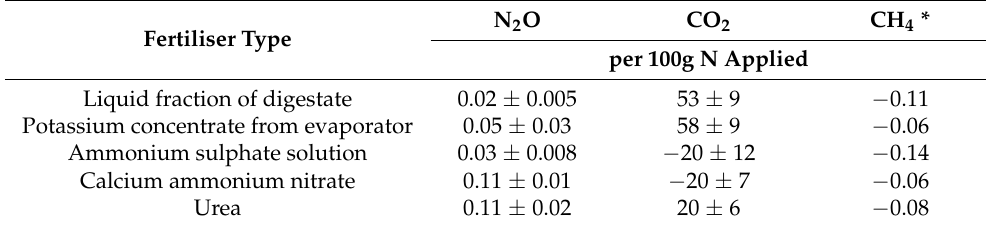
Table 5. Emission factors of nitrous oxide (N 2 O), carbon dioxide (CO 2 ), and methane (CH 4 ) expressed per 100 g of N applied for tested bio-based fertilisers and mineral N fertilisers. N 2 O CO 2 CH 4 * Fertiliser Type per 100g N Applied Liquid fraction of digestate 0.02 ± 0.005 53 ± 9 − 0.11 Potassium concentrate from evaporator 0.05 ± 0.03 58 ± 9 − 0.06 Ammonium sulphate solution 0.03 ± 0.008 − 20 ± 12 − 0.14 Calcium ammonium nitrate 0.11 ± 0.01 − 20 ± 7 − 0.06 Urea 0.11 ±